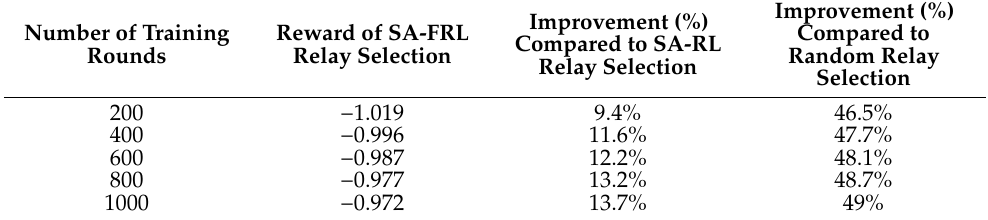
Table 5. Reward of SA-FRL with different amount of pre-training data, experimental channel.